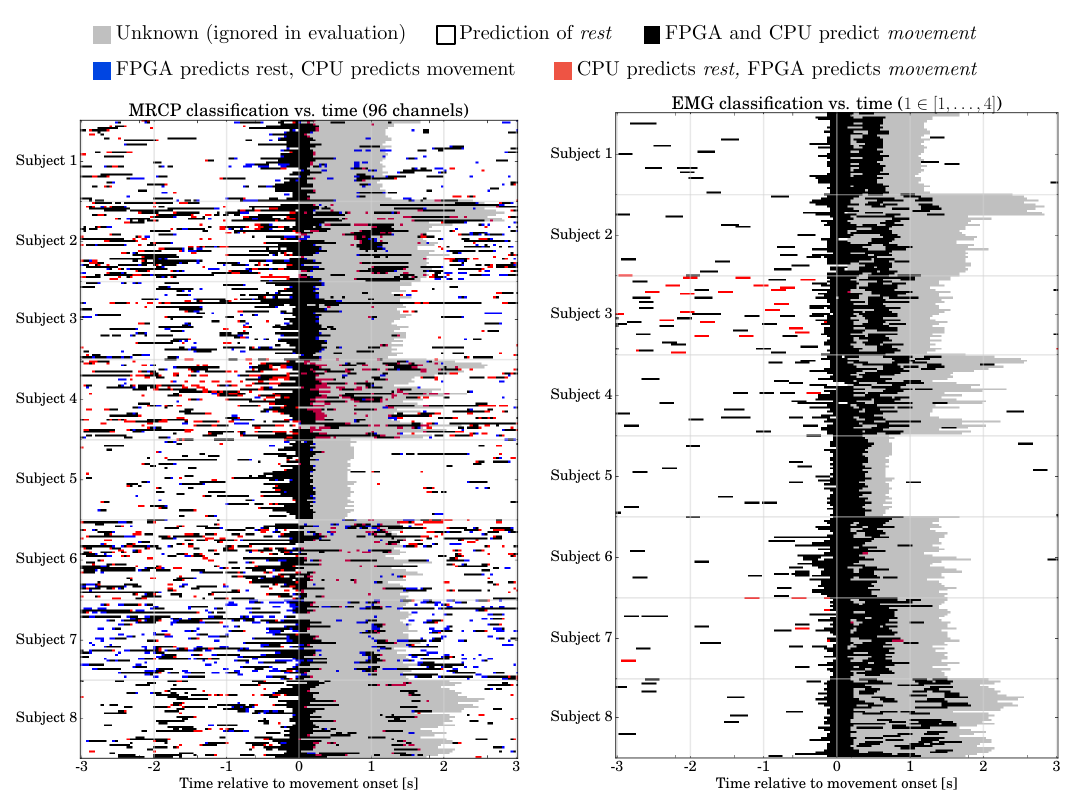
Figure 13. Predictions relative to the movement onset of the CPU and FPGA-based systems for the MRCP- and EMG-based movement prediction. The predictions of movements for the interval [ is depicted relative to each movement onset for MRCP-based predictions (left) and EMG-based predictions (right). Predictions of rest are left white, the unknown class subsequent to each movement is shown with a grey background. The prediction of a movement is encoded as follows: the prediction of a movement by the CPU-based systems as well as the FPGA-based system is shown in black. The prediction of a movement by the CPU-based system but not the FPGA -based system is shown in blue, the opposite case is shown in